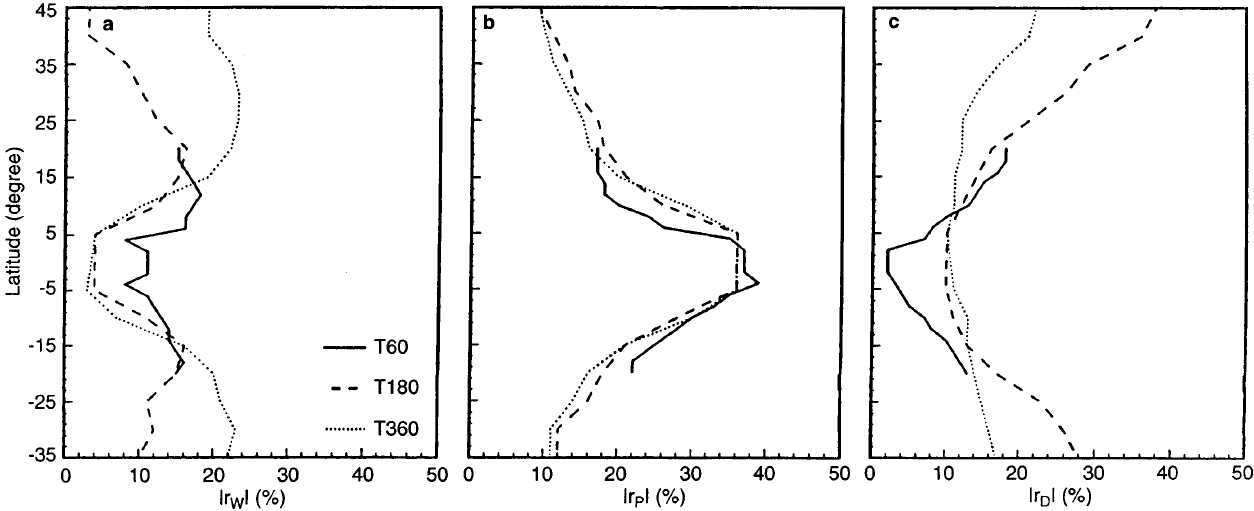
Fig. 9a–c. Linear energy flux coe(cid:129)cient (%) at di(cid:128)erent latitudes (degree) for di(cid:128)erent incident wave periods. a r